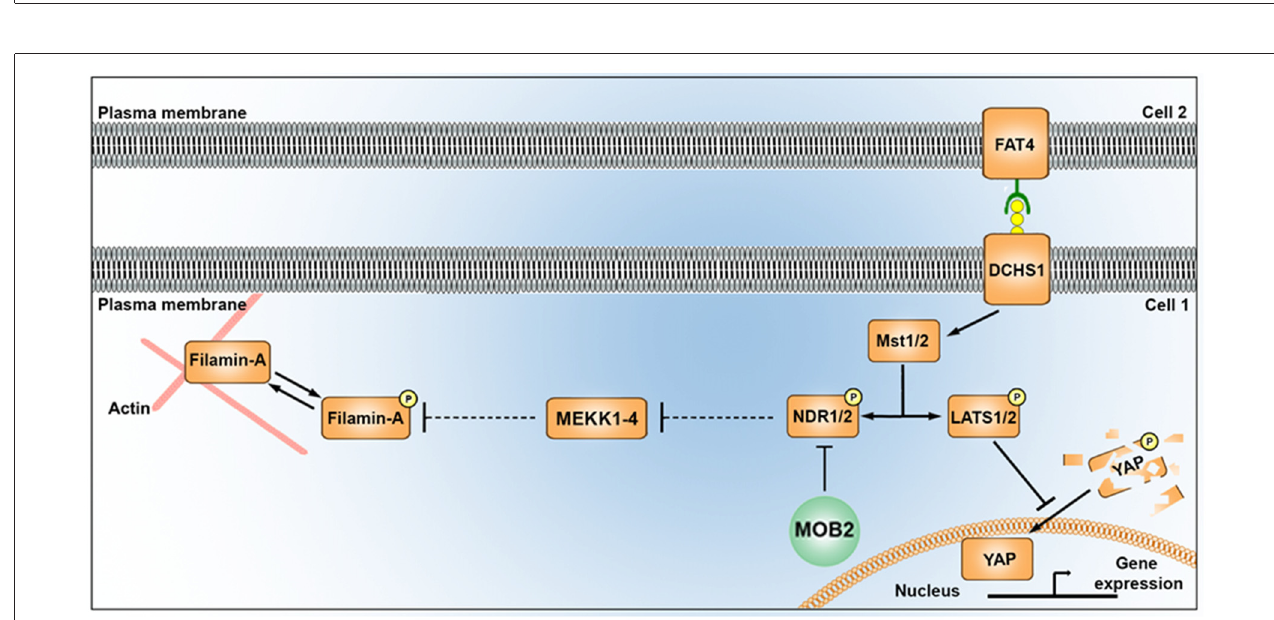
FIGURE 5 | Alterations in the mammalian Hippo signaling pathway alter FLNA phosphorylation. A schematic depicting the potential link between the Hippo signaling pathway and FLNA phosphorylation as outlined in this study. MST1/2 kinases (also known as “Hippo”), activated by FAT4/DCHS1, induces phosphorylation of YAP and NDR kinases. Phosphorylation of YAP leads to its degradation in the cytoplasm, while reduced activity of MST (e.g., via loss of DCHS1 activity) attenuates YAP phosphorylation and results in its translocation in the nucleus where it promotes changes to transcription. Phosphorylation of NDR1/2 facilitates its kinase activity. NDR1/2 kinases are further modulated by MOB1 (not shown) and MOB2 either positively or negatively, respectively. NDR1/2 kinases regulate the phosphorylation of the MEKK family of proteins, known modulators of FLNA phosphorylation (at site Ser 2152 ) and activity. In addition to disrupting nucleus-cilia coupling, reduced levels of MOB2 where seen in this study to induce changes in FLNA phosphorylation. A feature which could be mediated by the MEKK kinases given the associated supporting